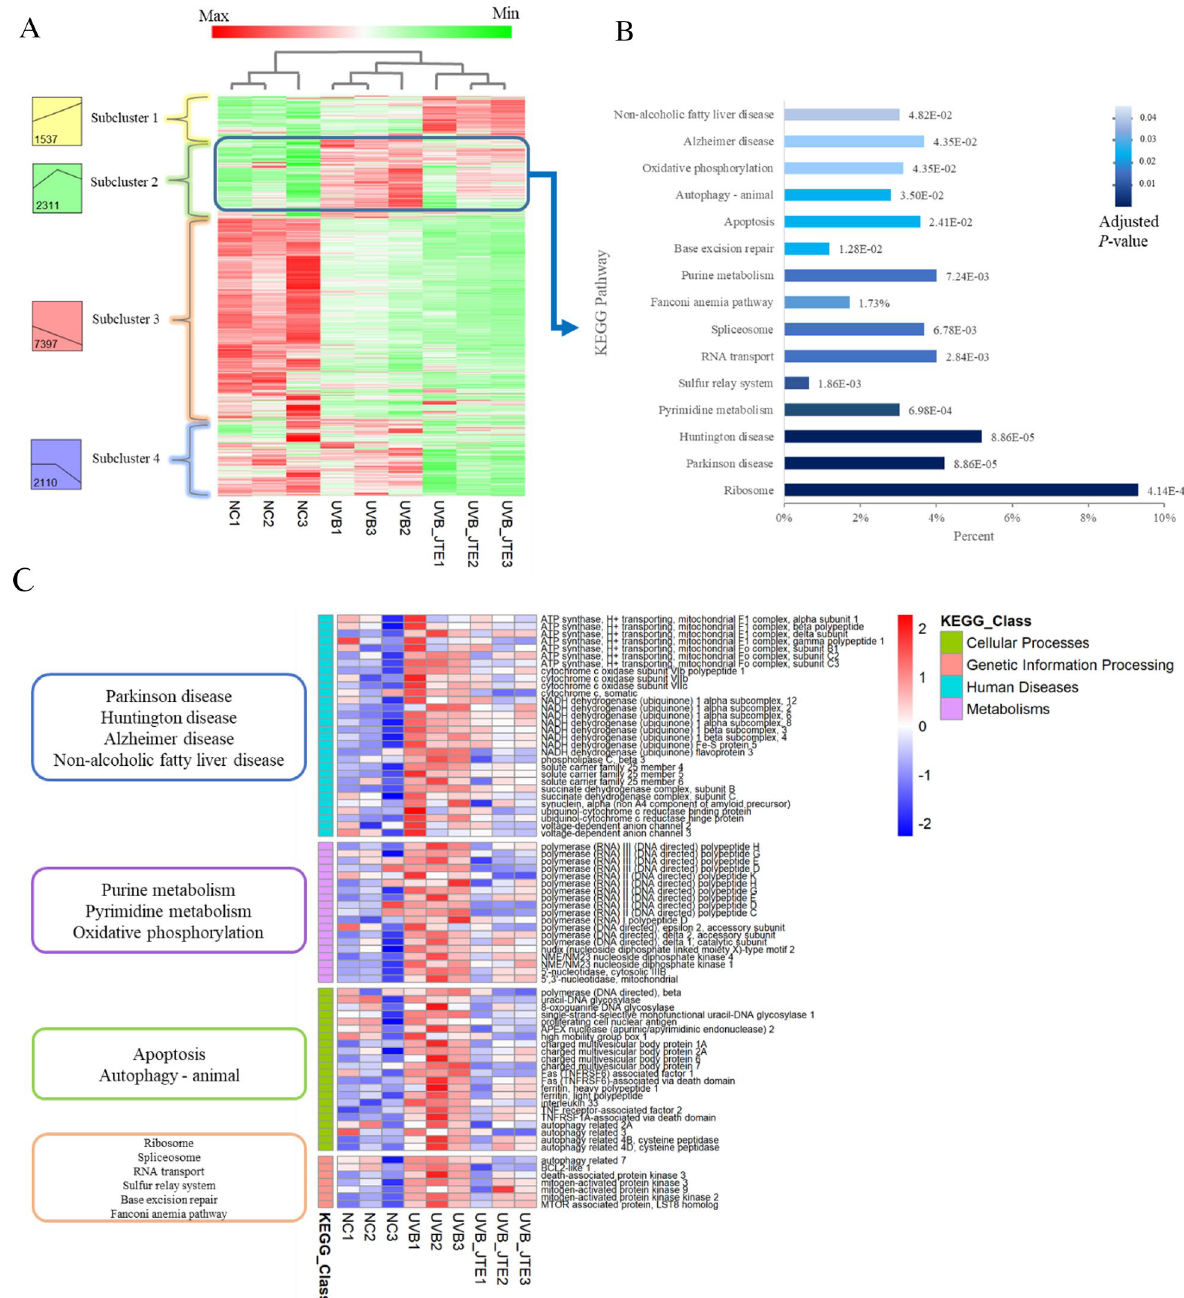
Fig. 7 The RNA-sequencing analysis on RPE cells. A Heatmap of 13,355 filtered genes expression and hierarchical clustering. Each cell represents a value of log 2 -normalized expression of gene. The boxes at the left show the number of genes with similar expression trend in one cluster. B The KEGG-pathway based enrichment analysis of genes expression, with adjusted P -value annotated at the right of the bar. C Heatmap of 78 genes involved in UVB-mediated cell damage and JET protecting